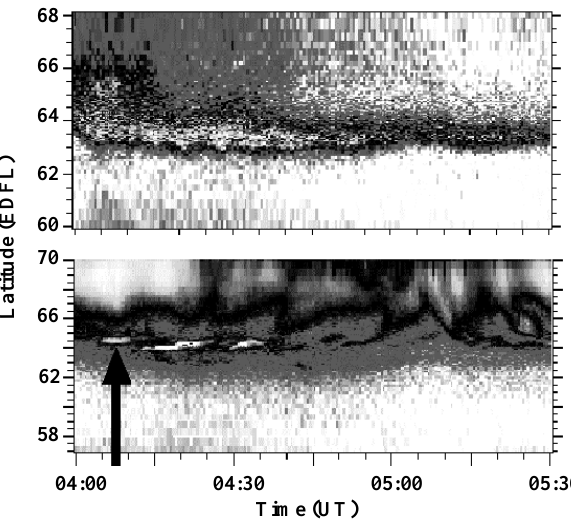
Fig. 6. Optical emissions at 486.1nm (top) and 630.0nm (bottom) from the high resolution MPA data from GILL. The grey scale for the 486.1 nm emissions ranges from zero R (white) to 15R (black) to 30R (white again). The maximum in the 486.1nm emissions is evident in the white band between 63 and 64 degrees latitude: the range of the 630.0nm emissions is 0 to 1000R. The FLRs (indicated by the arrow) are seen as white poleward moving bands (indicating a maximum in emissions of about